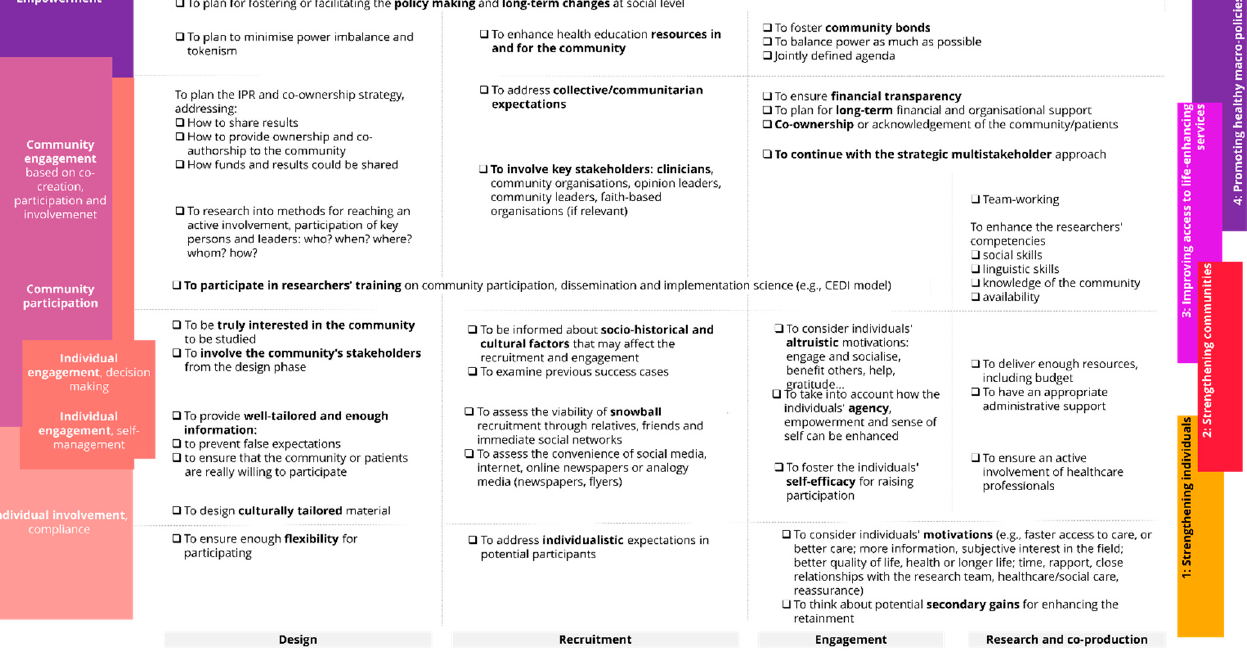
Figure 3. Checklist to promote community empowerment and individuals ′ engagement in research for person-centred care.